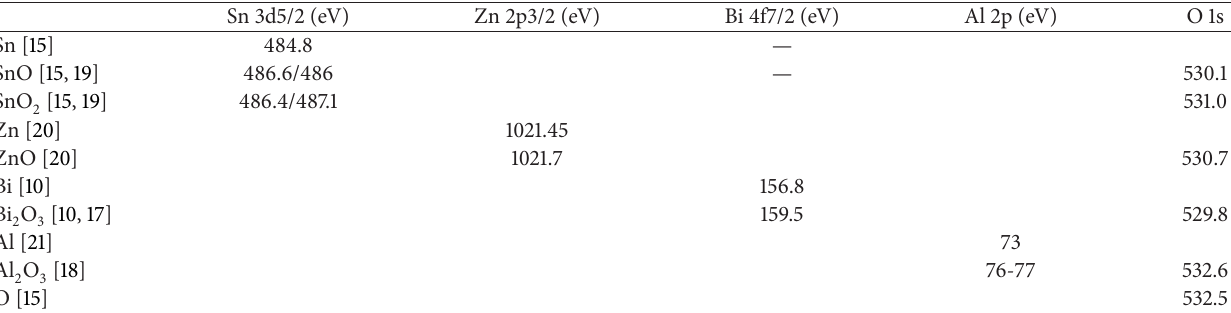
Figure 3: O 1s spectra of SBZ sample exposure at 170 ∘ C for 7min after etching for (a) 0s (initial surface), (b) 10s, (c) 80 s, and (d) 260 s. Table 1: XPS binding energy values for solder elements and the oxidative products obtained from literatures (Al, O data from NIST Standard Reference Database 20, V.